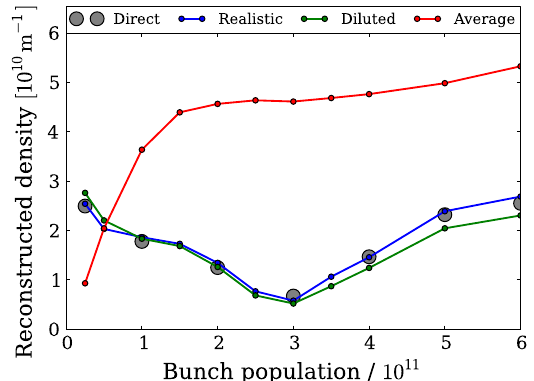
FIG. 15. Electron density in a dipole region reconstructed from the tune shifts using Eq. (19). The electron cloud density calculated directly from the macroparticle distribution in the buildup simulations is shown in